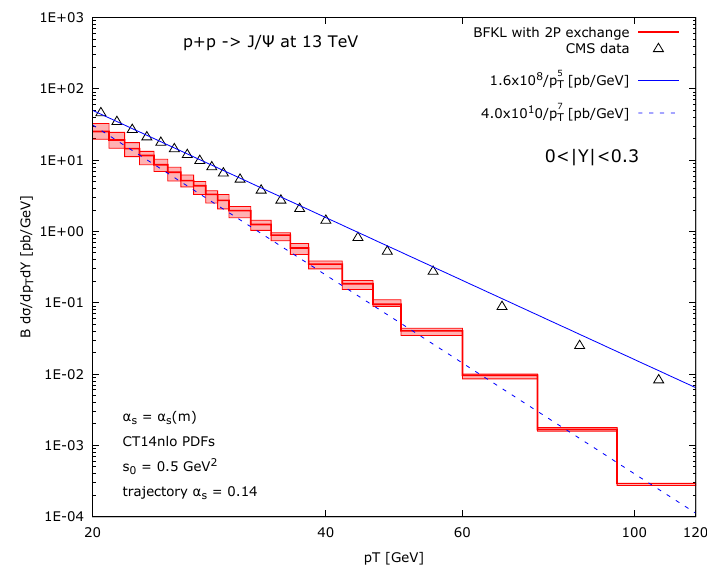
Figure 16 . The J/ψ cross section obtained with the fixed coupling constant α